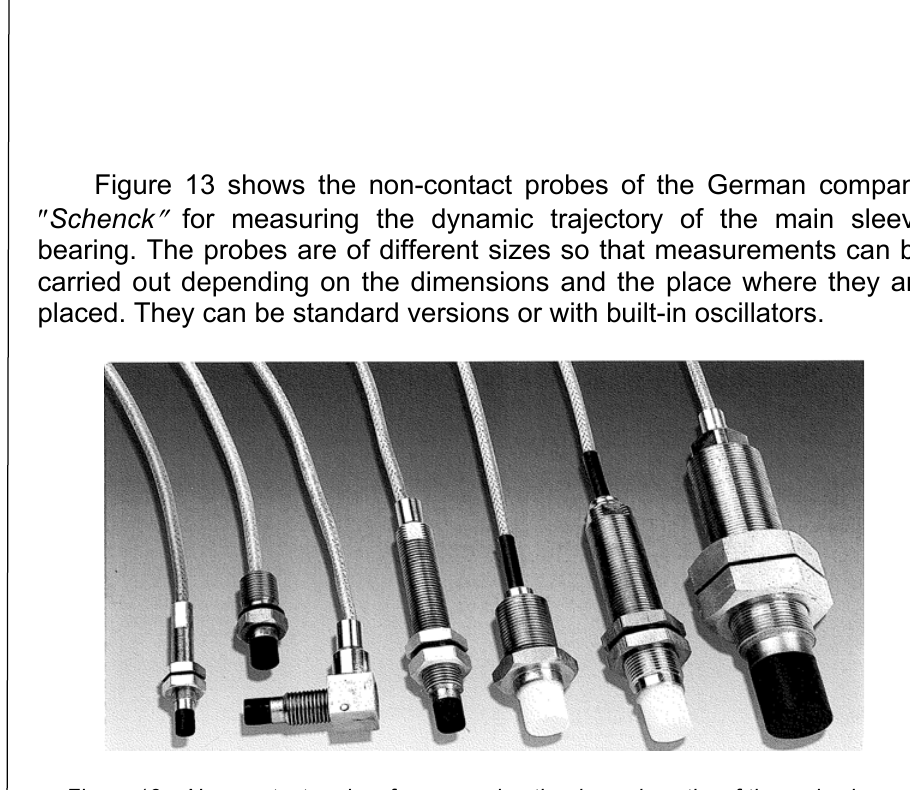
Figure 13 – Non-contact probes for measuring the dynamic paths of the main sleeve Рисунок 13 – Бесконтактные датчики для измерения динамических